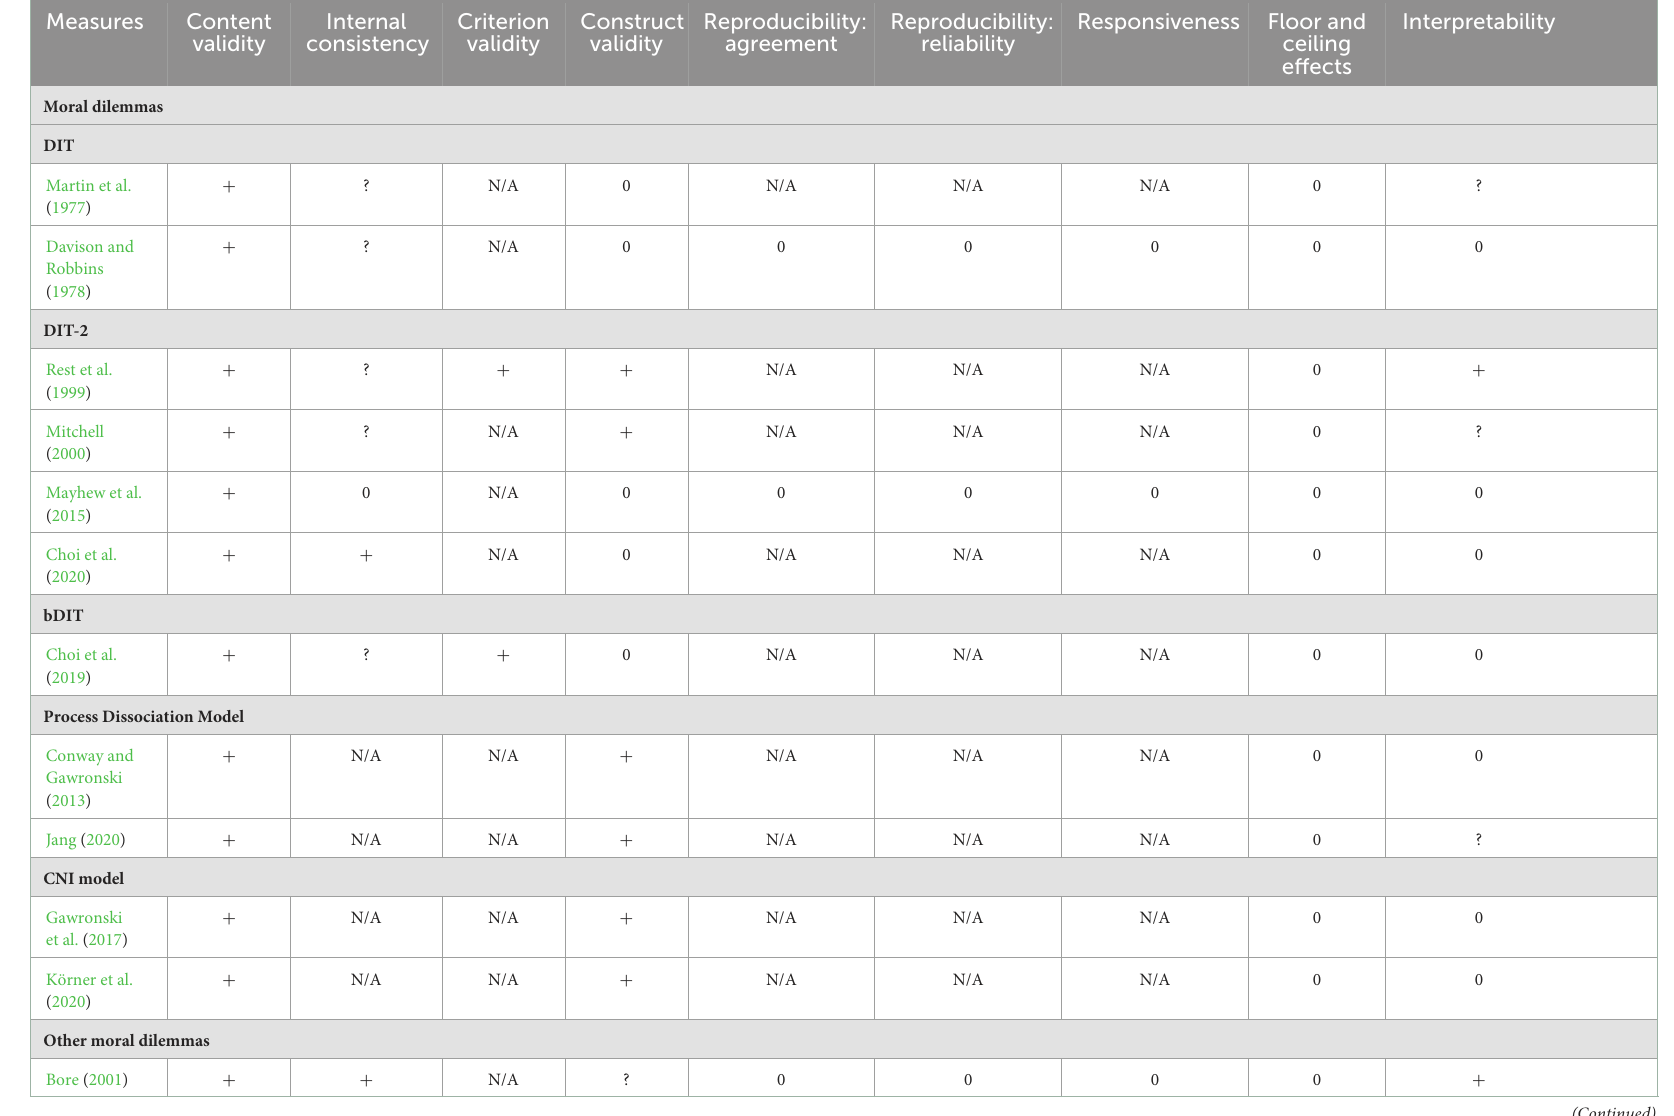
TABLE 5 Overview of scoring of psychometric properties in the included